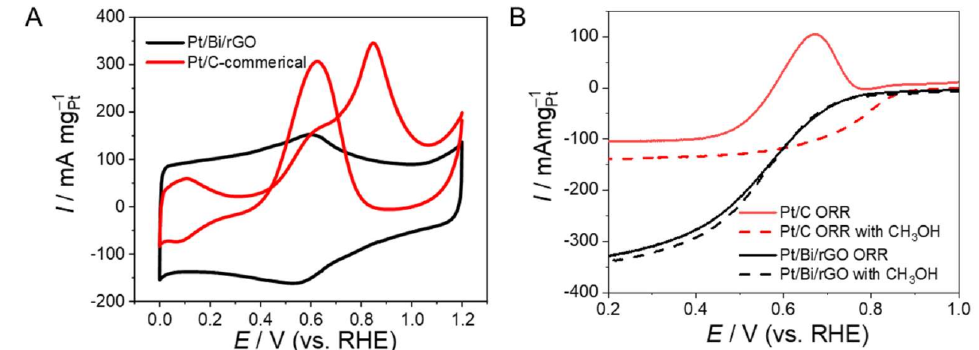
Figure 5. ( A ) CV curves measured in 0.5 mol/L H 2 SO 4 and 0.5 mol/L methanol aqueous solution for the Pt/C and ultra-small Pt/Bi/rGO catalysts, respectively. ( B ) Comparison of oxygen reduction properties in 0.5 mol/L H 2 SO 4 (dashed line) and 0.5 mol/L H 2 SO 4 + 0.5 mol/L methanol aqueous solution (solid line). All current densities are normalized against the mass of metallic Pt loaded onto the electrodes.